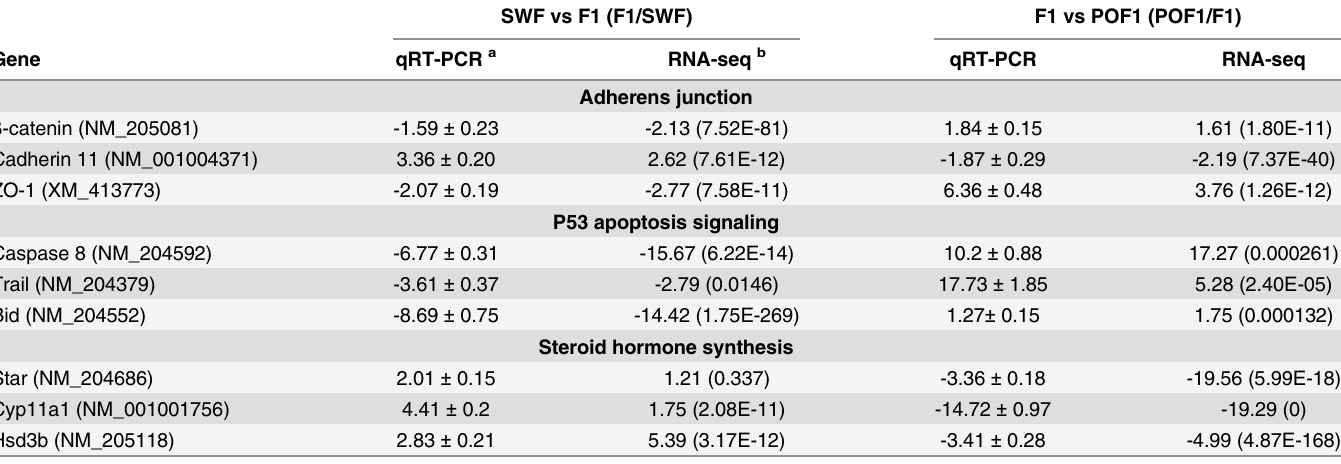
Table 3. Relative mRNA expression of 9 selected genes for comparisons of the SWF vs F1 and F1 vs POF1 follicles in respect to RNA-Seq and real-time